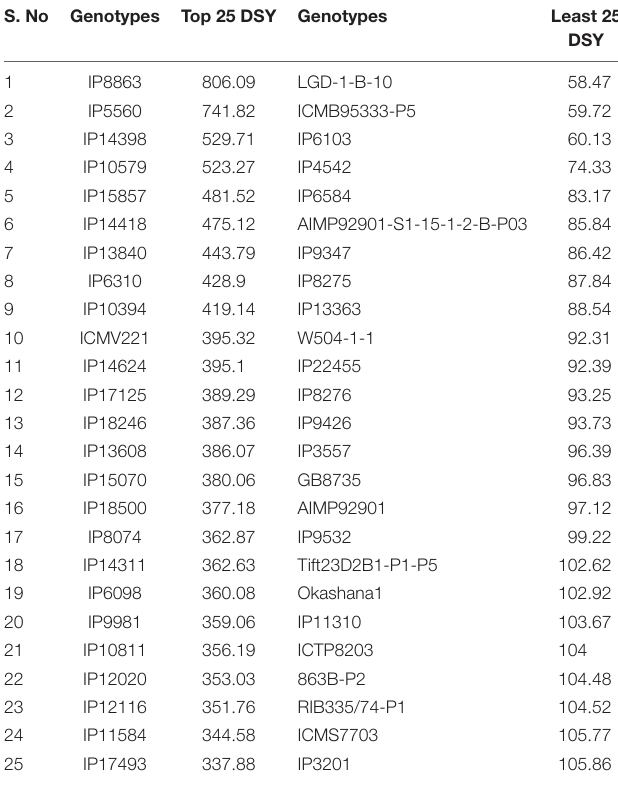
TABLE 4 | Dry stover yield (DSY) for top and least 25 genotypes under N 0 condition (derived from pooled data of three